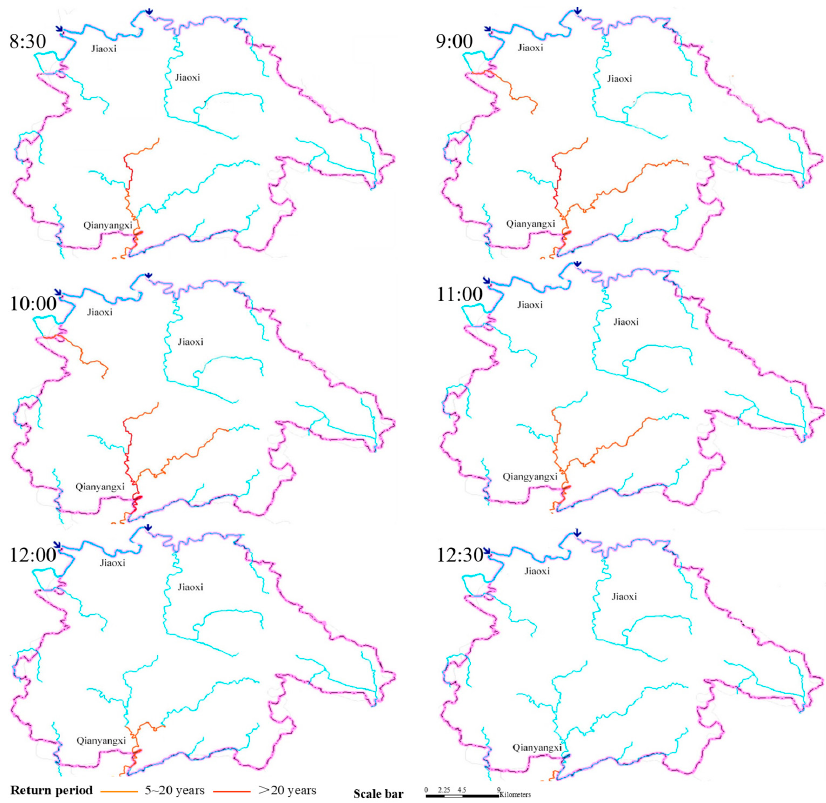
Figure 9. Warning map from 8:00 to 13:00 on 28 September 2016.